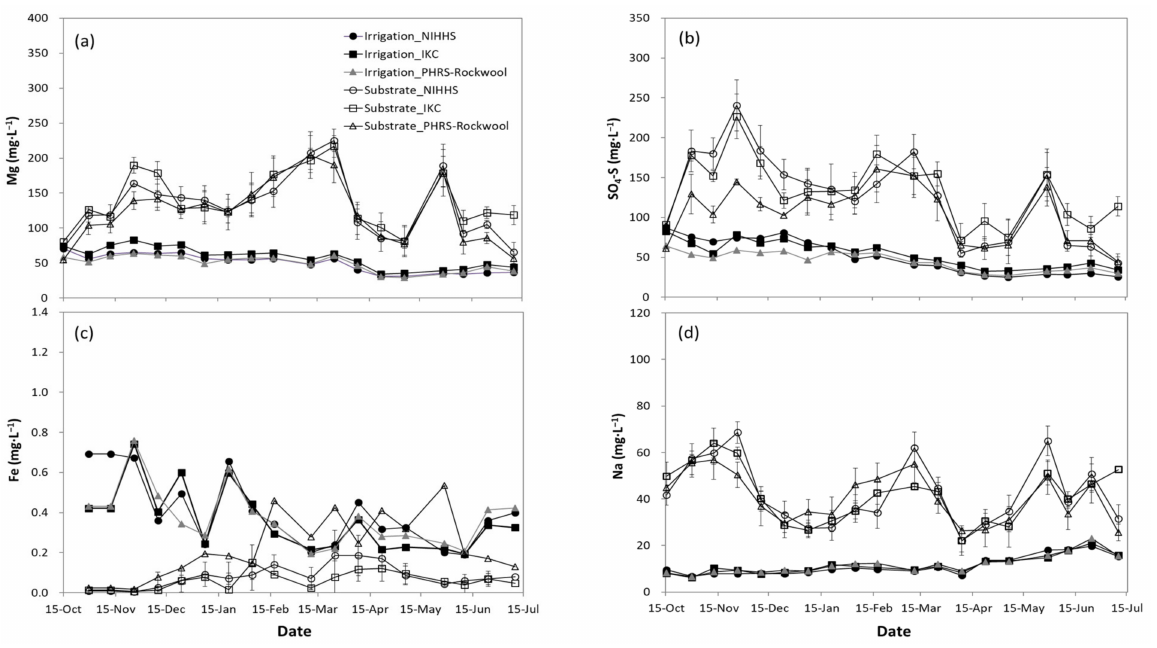
Figure 4. Changes in Mg ( a ), SO 4 -S ( b ), Fe ( c ), and Na ( d ) in the irrigation and RZ according to the compositions of the nutrient solutions: NIHHS, IKC, and PHRS-Rockwool, during the cultivation period. Vertical bars indicate standard errors of the means ( n =